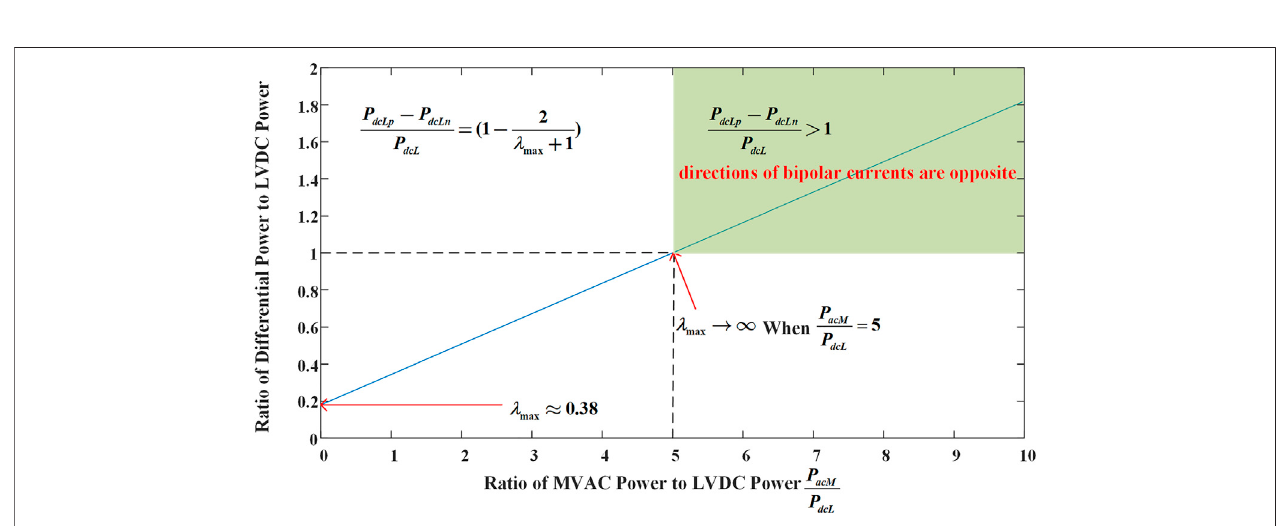
FIGURE 9 | Relationship between λ max and P acM / P dcL